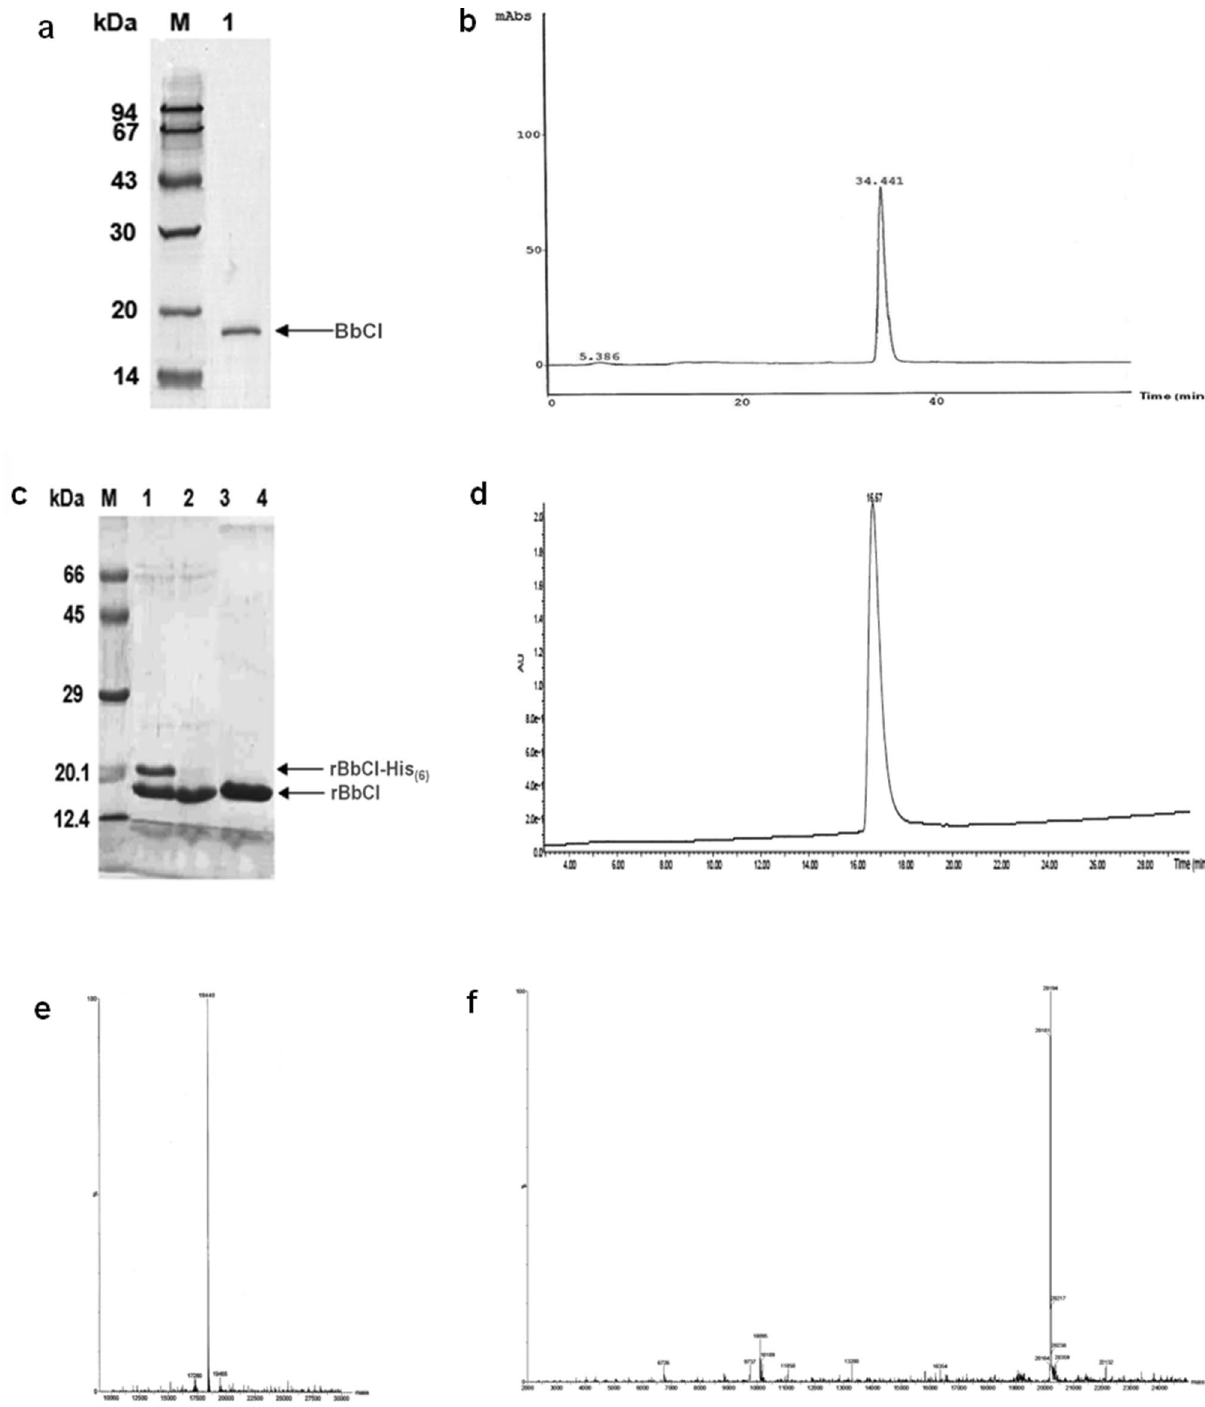
Figure 1 . Purity analyses of the inhibitors. SDS-PAGE (15%) stained with Coomassie-blue. (a) BbCI after reverse phase chromatography and under reducing conditions. (M) Molecular mass standard. (1) BbCI (30 µg). (c) rBbCI after the cleavage of the fusion peptide. M) Molecular mass standards. rBbCI subjected to cleavage with (1) 0.5 IU of thrombin after 1 h of incubation at 18 °C. (2) 0.5 IU of thrombin after 4 h of incubation at 18 °C. 3) rBbCI after thrombin cleavage (4 h) and gel filtrated in Superdex 75 equilibrated with 0.1 M Tris–HCl buffer (pH 8.0). The gels were scanned (HP Photosmart C4280) to obtain the images which are shown in black and white. The resize was realized to facilitate the comparison between protein migrations and the specific area of the image (c) was cropped using the GIMP (GNU Image Manipulation Program) Portable, image editor. The gels are presented in a Supplementary Information file. Reverse-phase chromatography. HPLC system, C18 protein/peptide column (15 cm × 4.6 mm; Vydac) equilibrated with 0.1% TFA in water, and elution with 90% acetonitrile gradient (0 to 90%) (b) BbCI and acetonitrile gradient (5 to 95%) (d) rBbCI. Chromatography performance at room temperature and flow rate of 0.7 mL/min. LC/MS analysis. Mass spectrometer, 3100 model coupled with a system Alliance model 2690, Waters Nova-Pak C18 column (2.2 × 150 mm, 3.5 µm particle size, 60 A° pore size. The solvents used were: A: 0.1% TFA/H 2 O and B: 90% CH3CN/A; with a gradient: 5–95% B for 30 min at 250 µL/min, λ: 214 nm and mass range: 200–2000 m/z (e) rBbCI and (f) rBbCI-His (6)